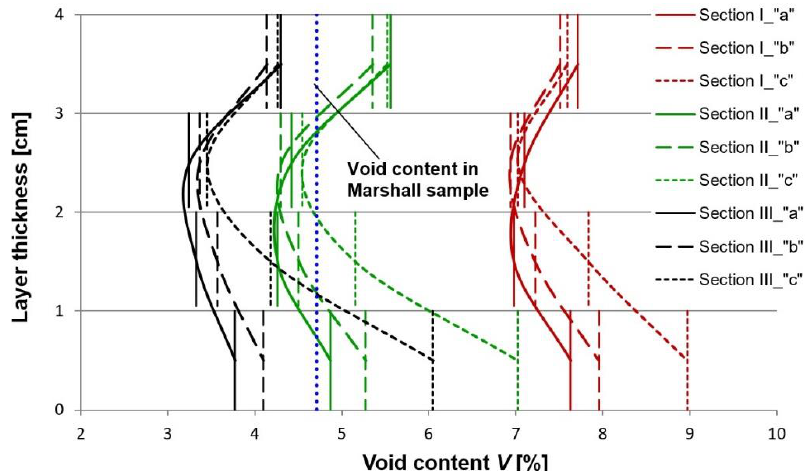
Figure 8. Air void content (Vm) in the 4 cm thick binder course, determined on the sliced specimens,